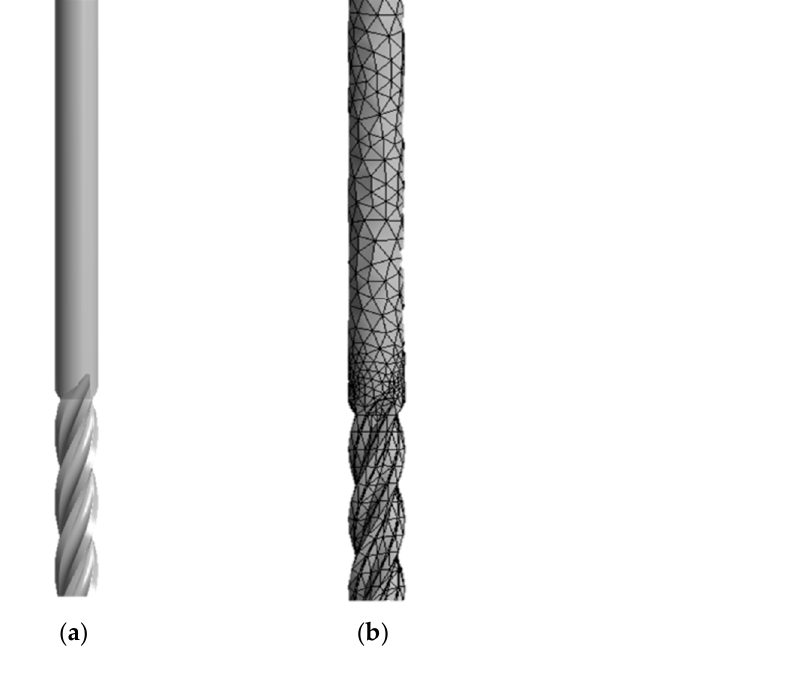
Figure 2. ( a ) CAD model of the 4 flute endmill and ( b ) Model with mesh geometry.